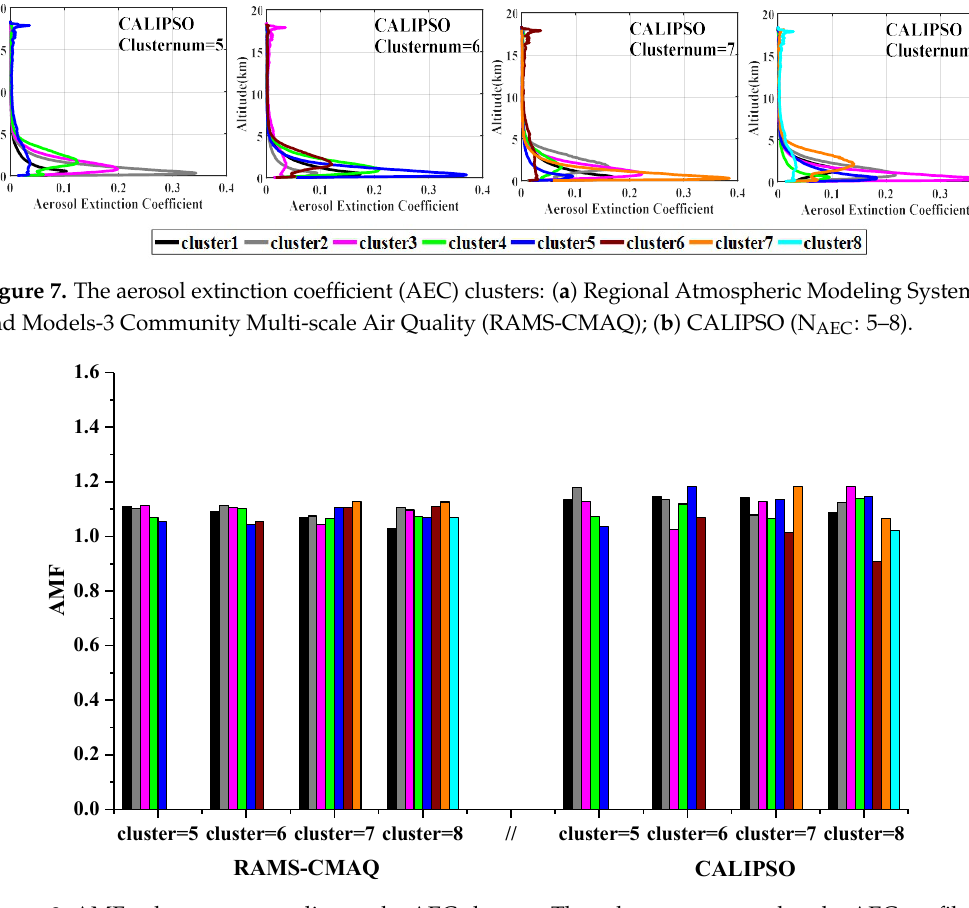
Figure 8. AMF values corresponding to the AEC clusters. The colours correspond to the AEC profiles in Figure 7 for each cluster.